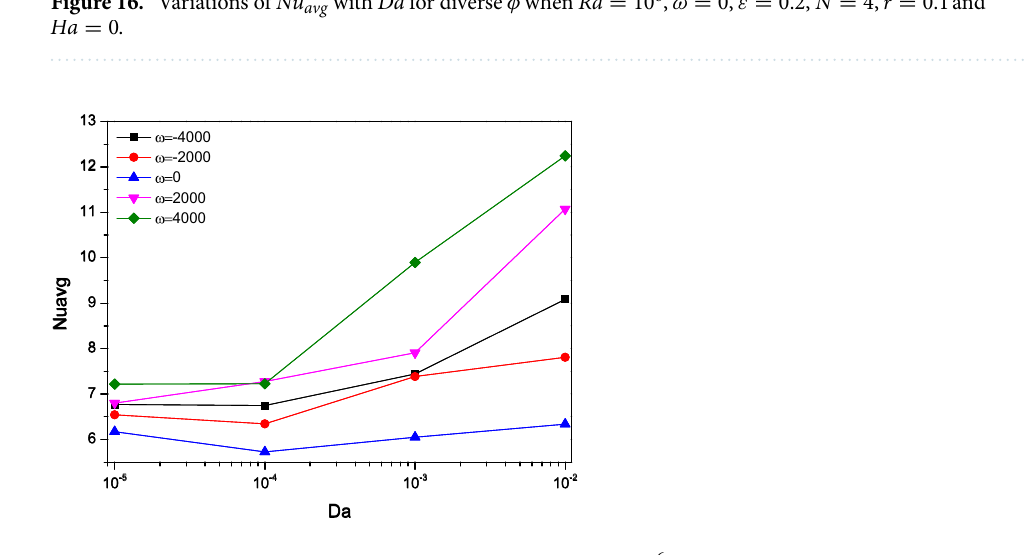
Figure 17. Variations of Nu avg with Da for diverse ω when Ra = 10 6 , ε = 0.2 , φ = 0.02 , N = 4 , r = 0.1 and Ha = 0